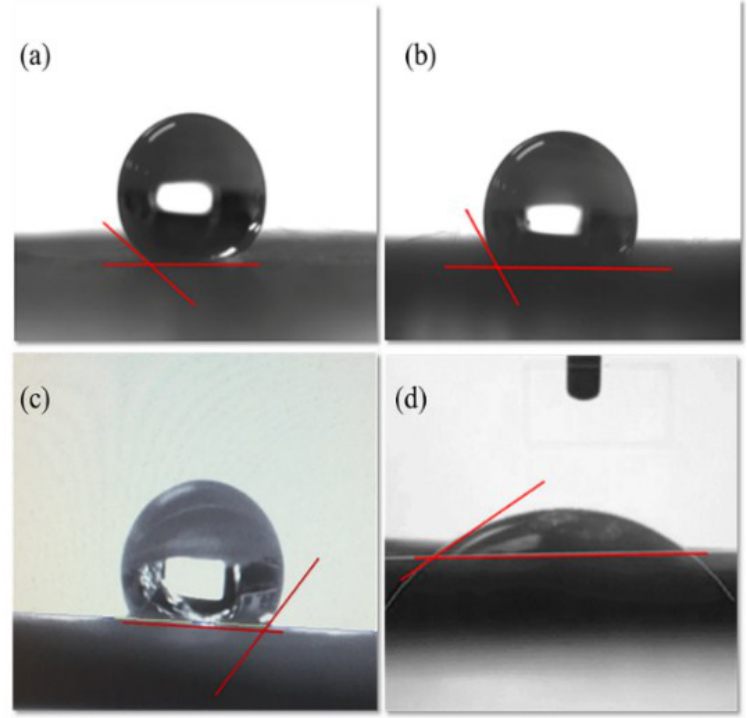
Figure 4. Contact angles of water droplets in air on different samples: ( a ) rTAC-p; ( b ) rTAC-n; ( c ) TiO 2 /rTAC-p; and ( d ) GO/rTAC-p.